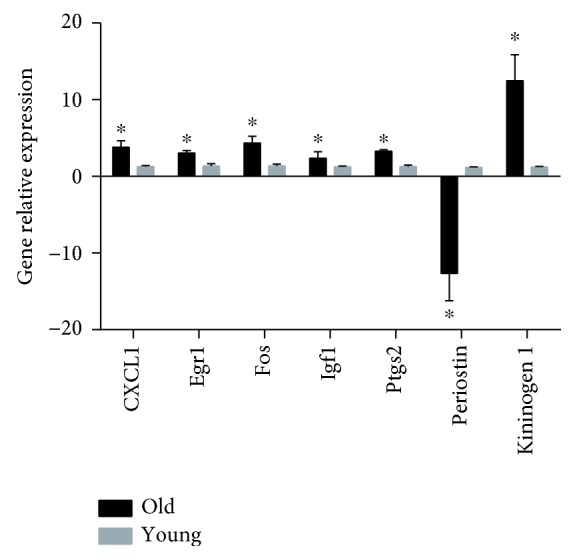
Validation of microarray results by RT-PCR. Five hub genes (Cxcl1, Egr1, Fos, Igf1, and Ptgs2) and the most significantly upregulated (kininogen 1) and downregulated (periostin) genes were selected for the real-time PCR validation. GAPDH was selected as the internal control. Data are presented as the mean ± SD. ∗
P < 0.05 compared with the young group.